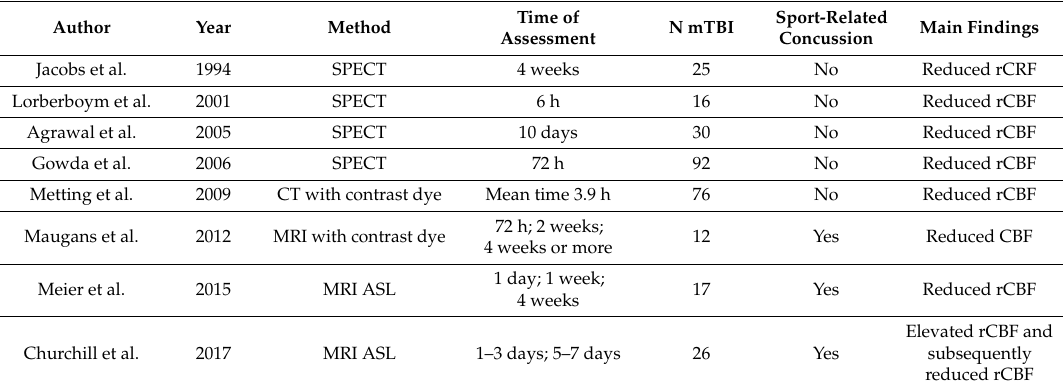
Table 2. Regional cerebral blood flow within 4 weeks from